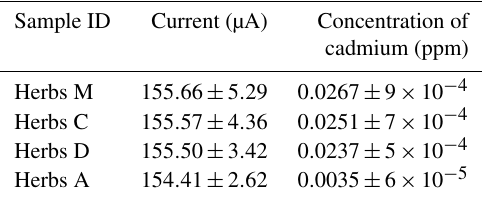
Table 2. Determination of concentration of cadmium in herb sam- ples under optimized conditions using an optimized electrochemical sensor with a G–IL modified SPCE.